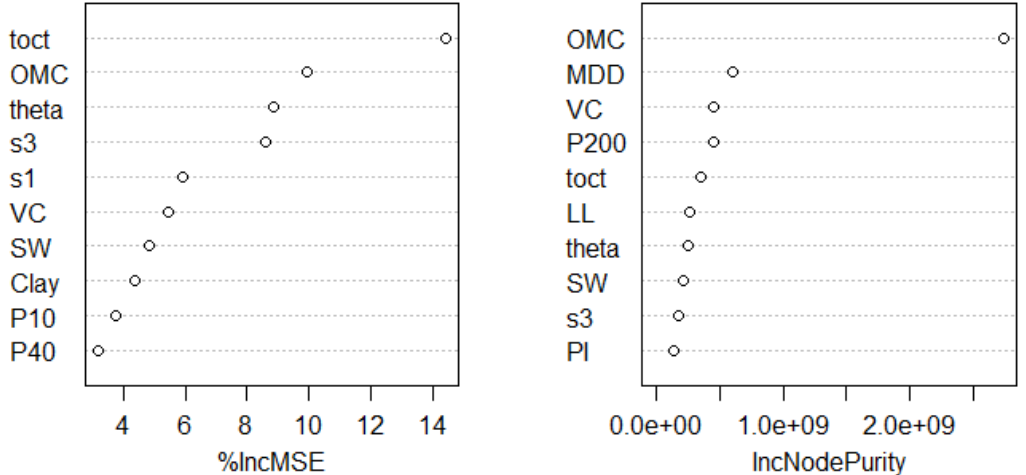
Figure 8. Importance of top 10 variables by percent increment in MSE and increment in node purity (the RF model).